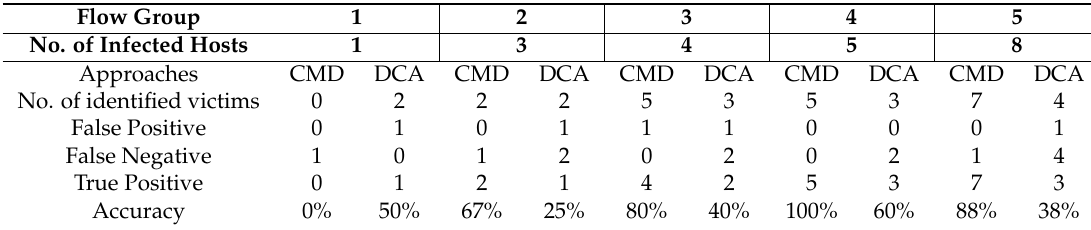
Table 7. Evaluated comparison of the Cascading Motif Discovery-based method and Destination-source Correlation Algorithm for each flow group under the polyworm simulated